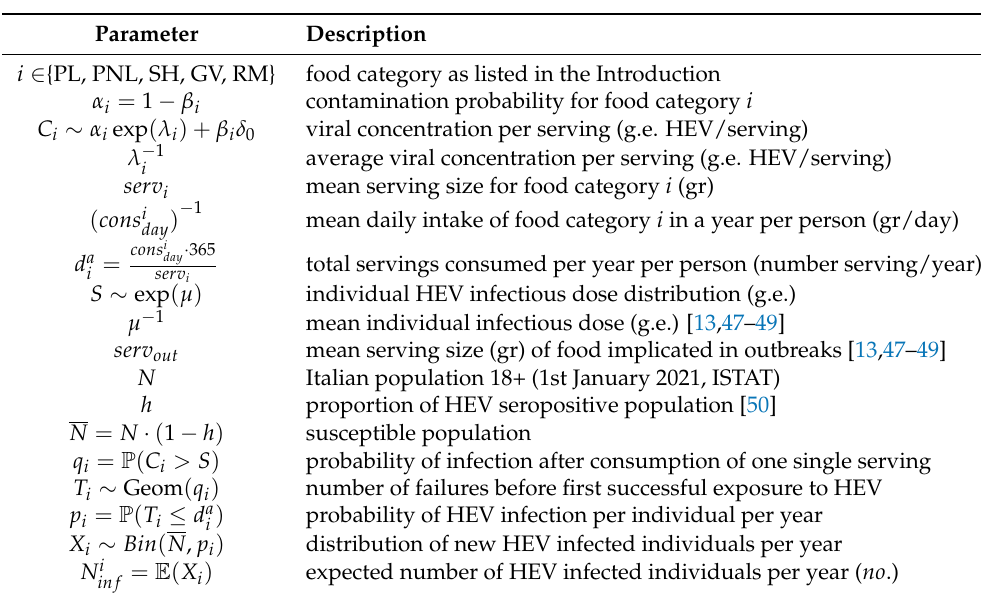
Figure 1. The model sketch. Table 1. Model